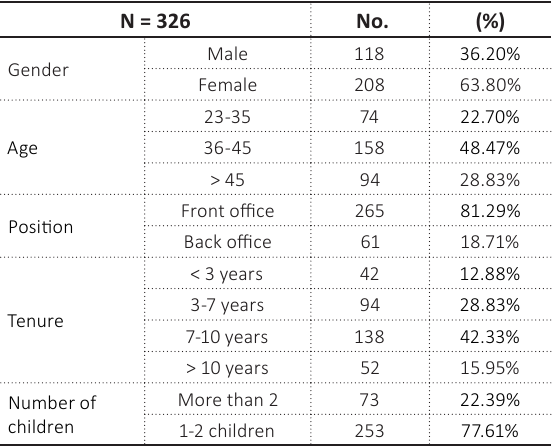
Table 1. Demographical analysis of the respondents